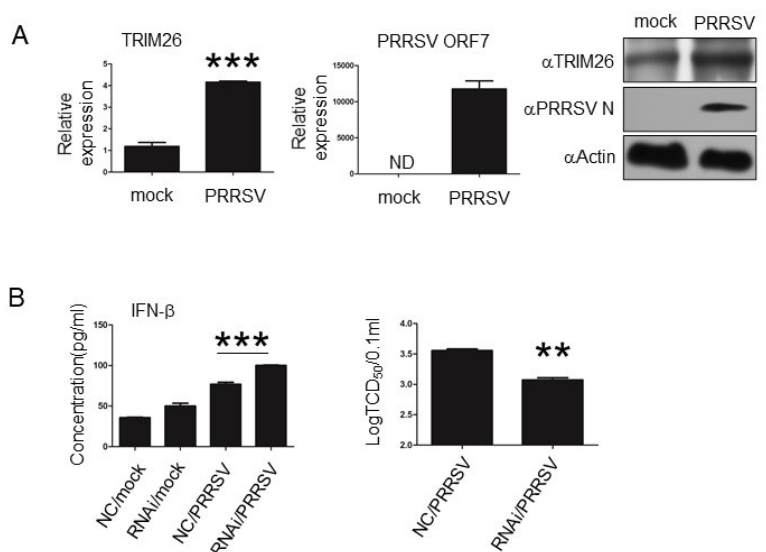
Figure 5. E ff ect of porTRIM26 on IFN- β expression and porcine reproductive and respiratory syndrome virus (PRRSV) infection in PAM. ( A ) PAM were infected with PRRSV at a MOI of 1 for 24 h. The mRNA levels of TRIM26 and PRRSV ORF7 were measured with RT-qPCR. The protein levels of TRIM26 and PRRSV N were measured with Western blotting. PRRSV infection induced expression of TRIM26. ( B ) PAM were transfected with the porTRIM26 siRNA or NC siRNA. After 72 h, cells were mock-infected or infected with PRRSV at an MOI of 1. Supernatants were collected at 24 hpi for either a TCID 50 assay or ELISA. The knock-down of porTRIM26 expression increased the production of IFN-b and inhibited PRRSV infection. Data are mean ± SEM pooled from one independent experiment; n ≥ 3 for each of the analyzed parameters. ND: not detected. **, p < 0.01; ***, p < 0.001 in comparison: mock-infected vs. PRRSV-infected group ( A ); NC-siRNA-transfected vs. porTRIM26 -siRNA-transfected cells after infection with PRRSV ( B ).